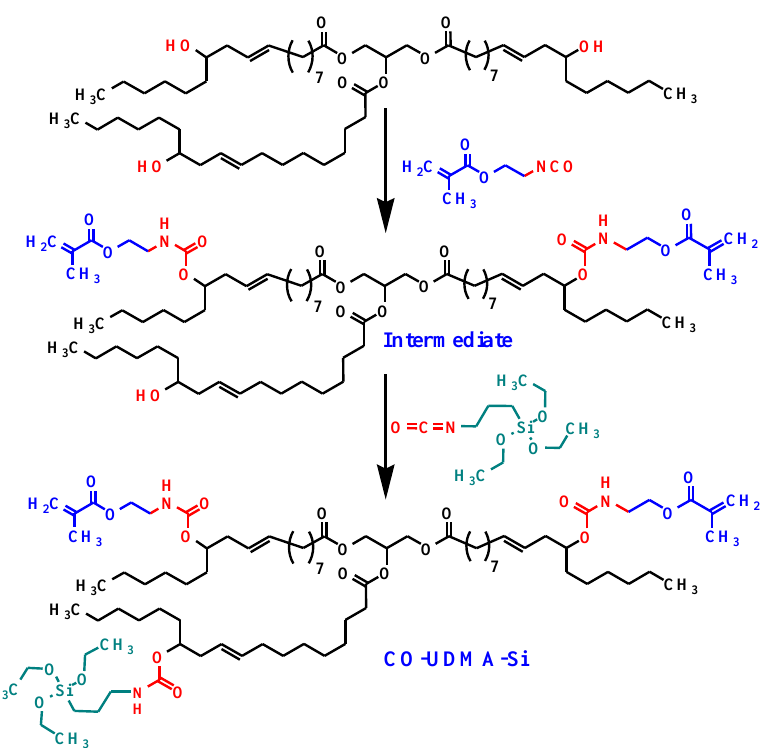
Figure 1. Schematic diagram of Castor Oil Urethane Dimethacrylate with Silane Sequences (CO-UDMA-Si) monomer preparation.